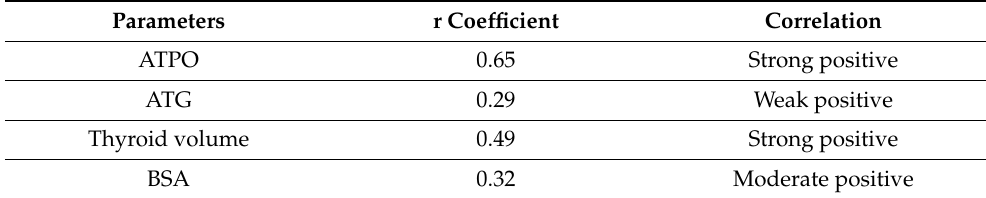
Table 3. Correlation between SR and different parameters.